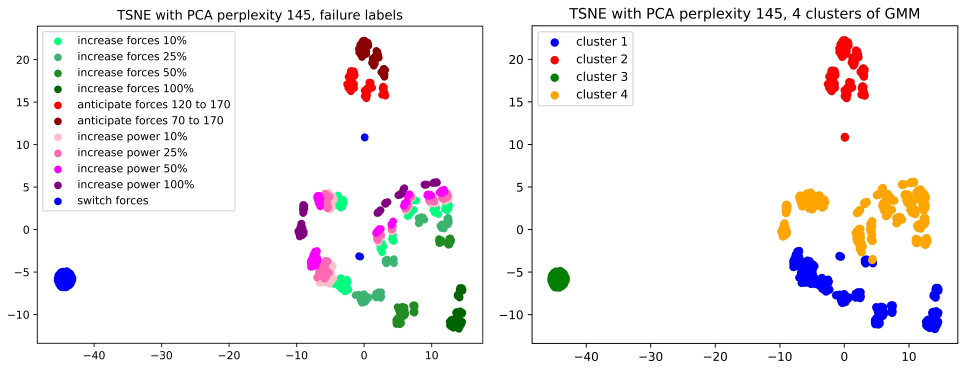
Figure 5. 2 t -SNE space images, containing failure labels in the left part, and GMM clustering labels in the right